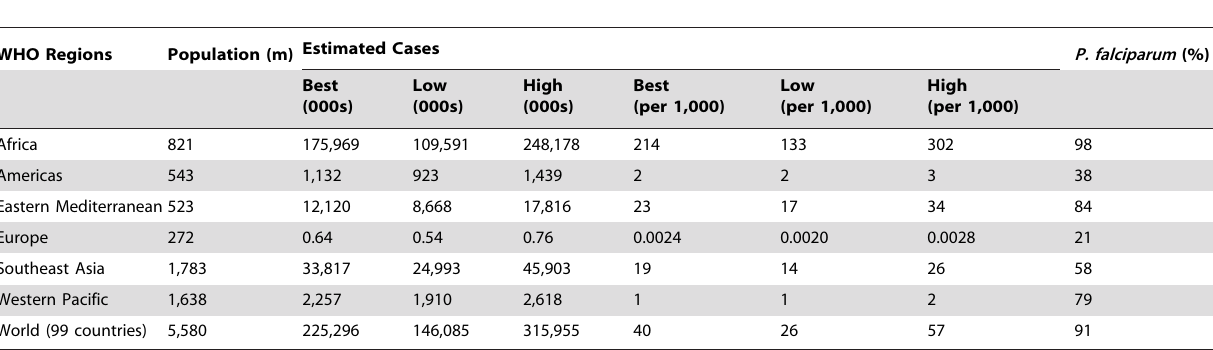
Table 3. Estimated number of all malaria cases in 2009 and the percentage of estimated cases that were due to infection with P. falciparum .